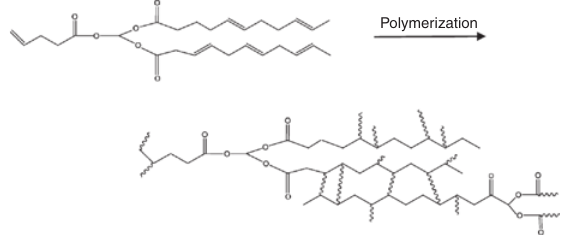
Scheme 1: The polymerization of vegetable oil.